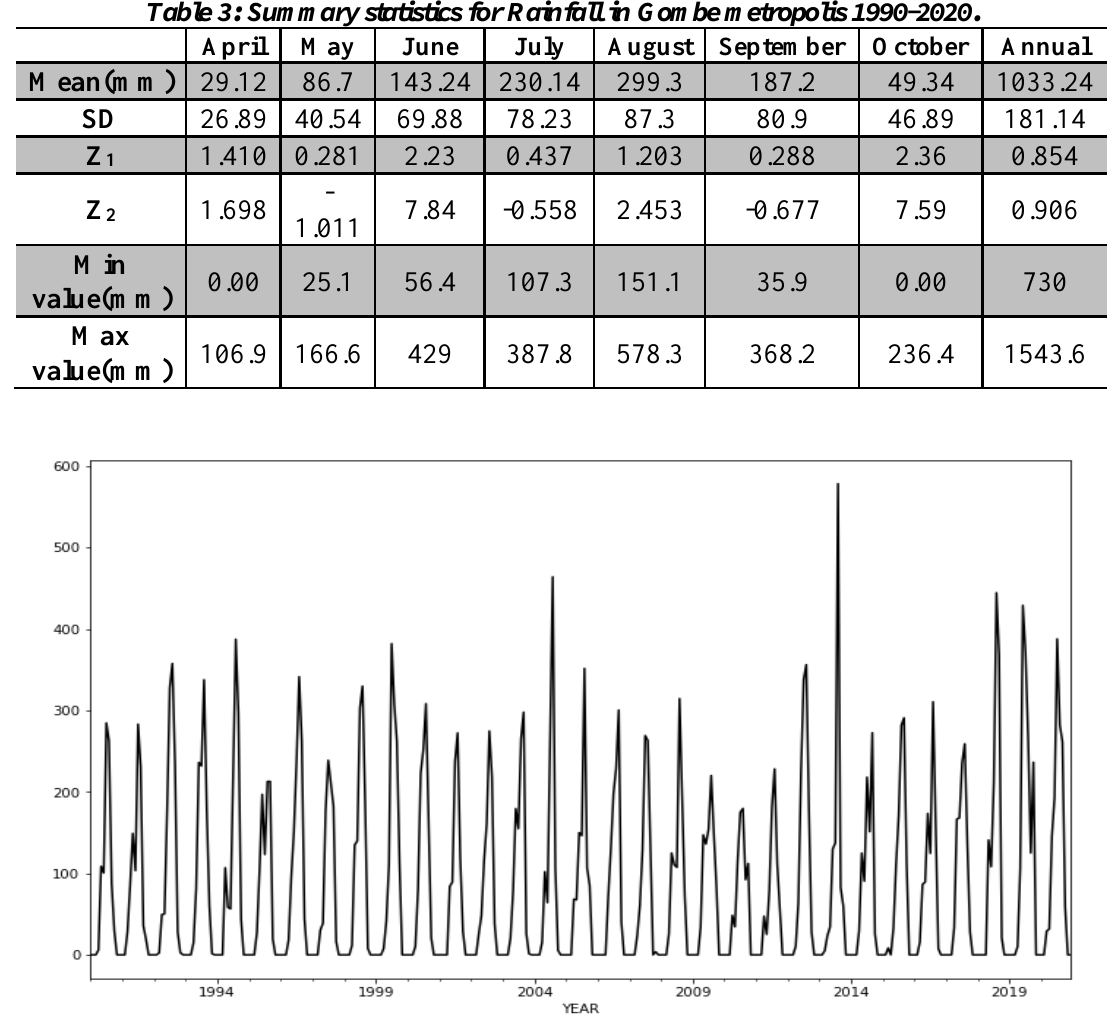
Figure 4: Time series plot of monthly rainfall from 1990 to